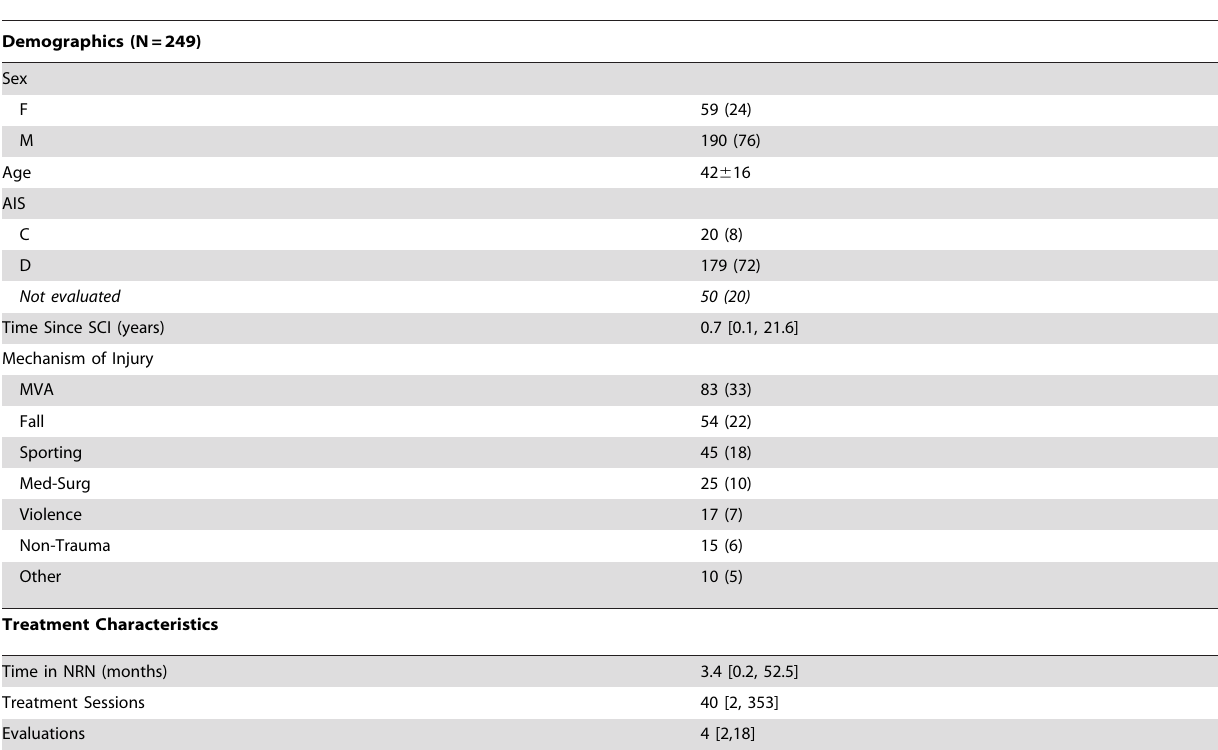
Table 1. Demographic, clinical, and treatment